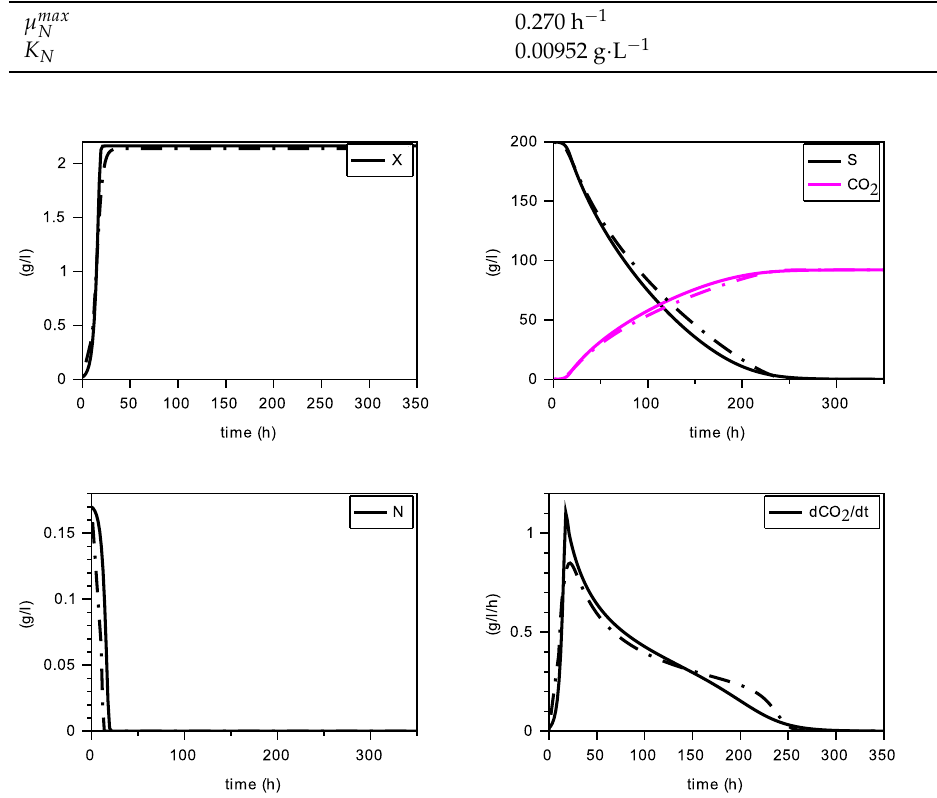
Figure 8. Comparison with the SOFA model (in dashed) for N ( 0 ) = 0.170 g · L − 1 (constant tempera- ture of 24 ◦